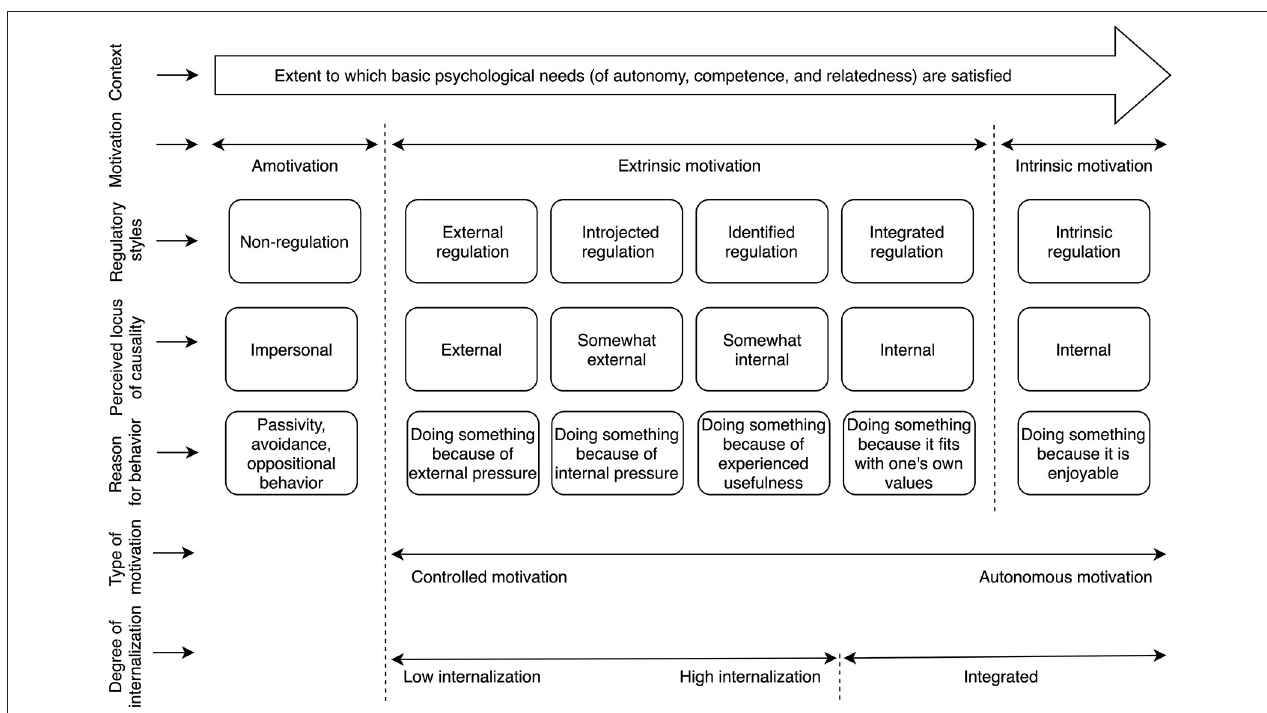
FIGURE 1 | Schematic representation of Organismic Integration Theory. Source: Poraj-Weder et al.